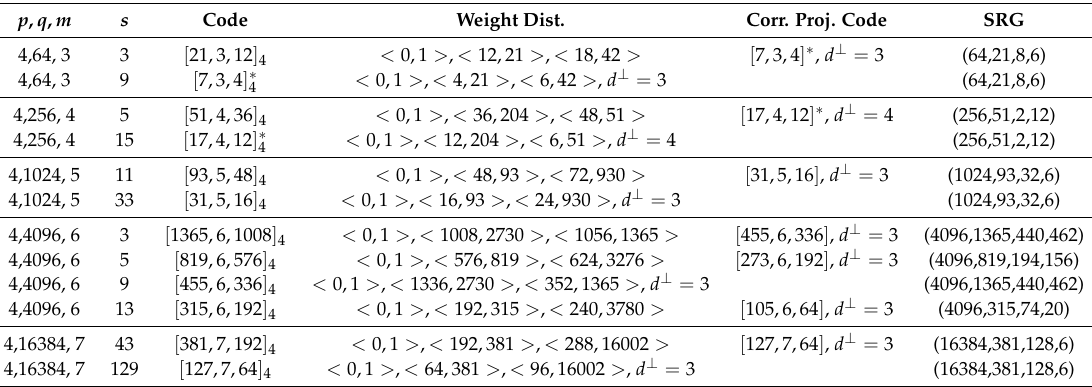
Table 7. Two-weight quaternary trace